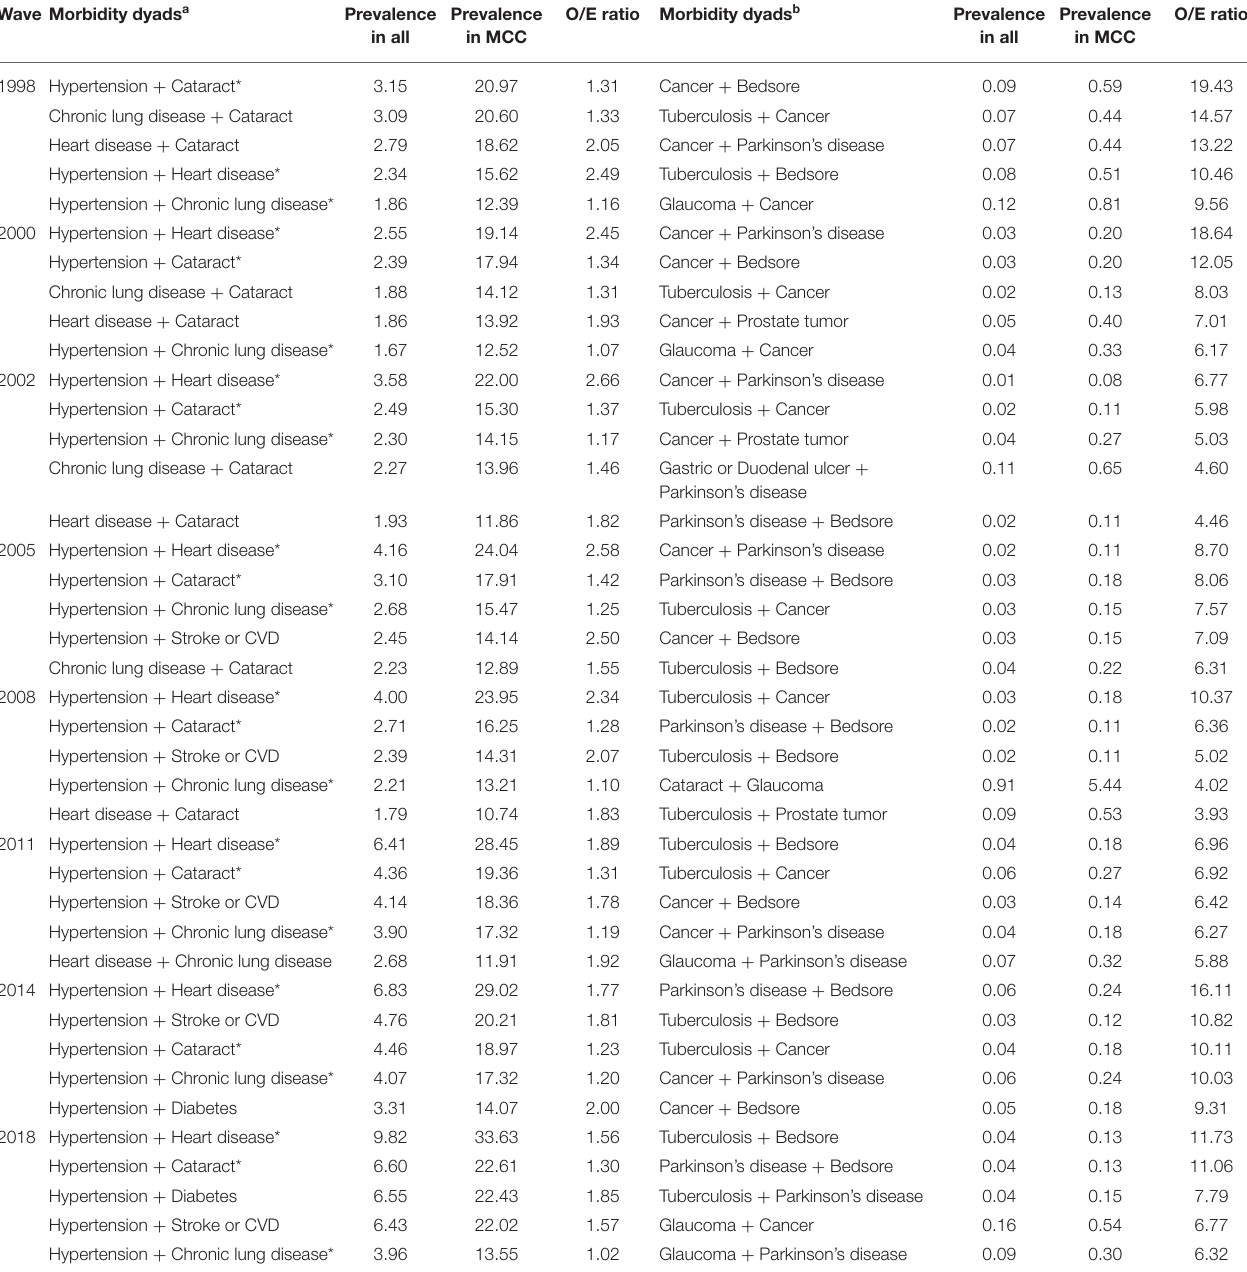
TABLE 3 | Prevalence and observed-to-expected ratio (O/E) of the five most common and prevalent multimorbidity combinations for the survey of eight waves. Wave Morbidity dyads a Prevalence